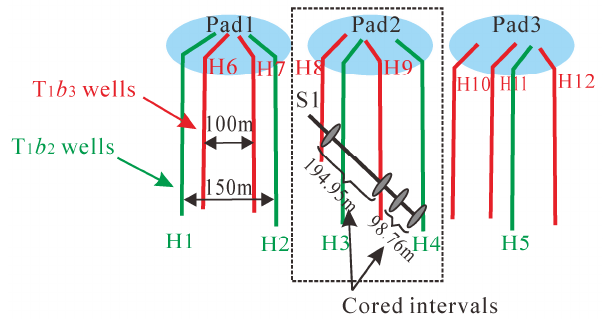
Figure 1. Plan view of twelve horizontal wells and the slant core well in the CHFTS. The slant core well is in black, and goes through the fractures of H8/H9 in the T 1 b 3 and H4 in the T 1 b 2